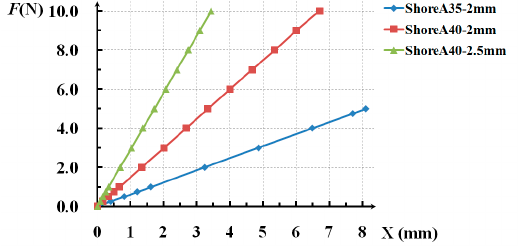
Figure 6. Simulated stiffness of the pneumatic bladder under different combinations of material hardness and wall thickness.